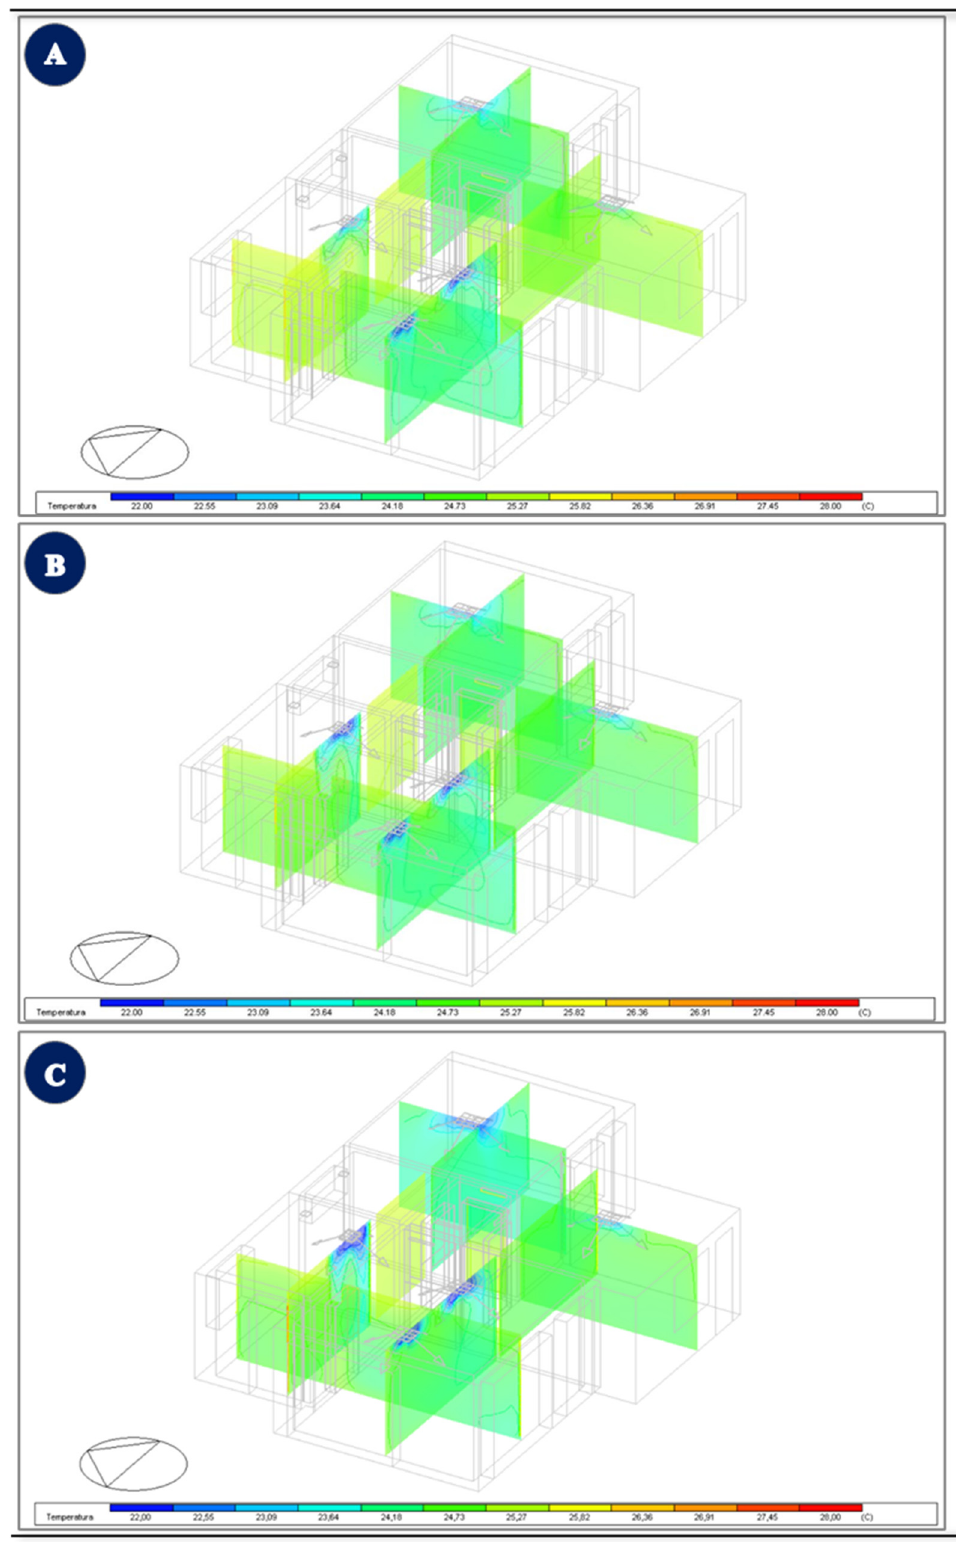
Figure 10. 2D distribution of air temperature on 30 July at: ( A ) 10:00, ( B ) 14:00, and ( C ) 18:00.